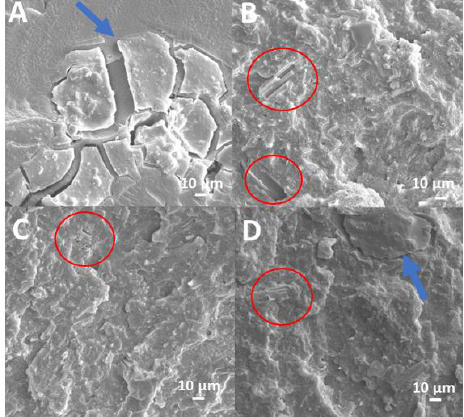
Figure 3. Typical SEM micrographs of fracture surfaces for EVA+HA ( A ), EVA/HHB 20 ( B ) and EVA/HHB40 ( C ), and EVA/HHB20+HA ( D ).